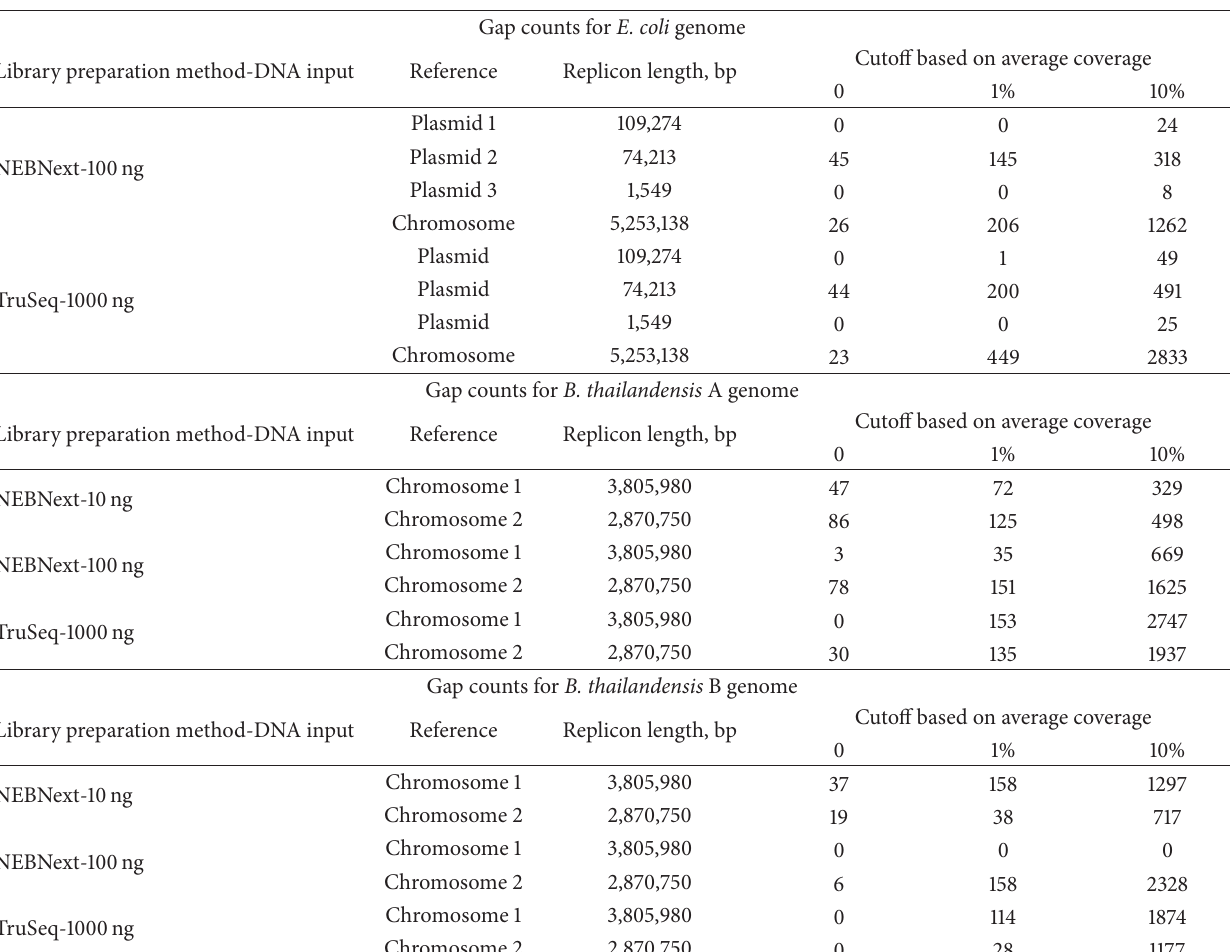
Table 1: Comparison of gap counts by organism, replicon, and library preparation method. Input DNA amount for each sample follows the name of the library preparation